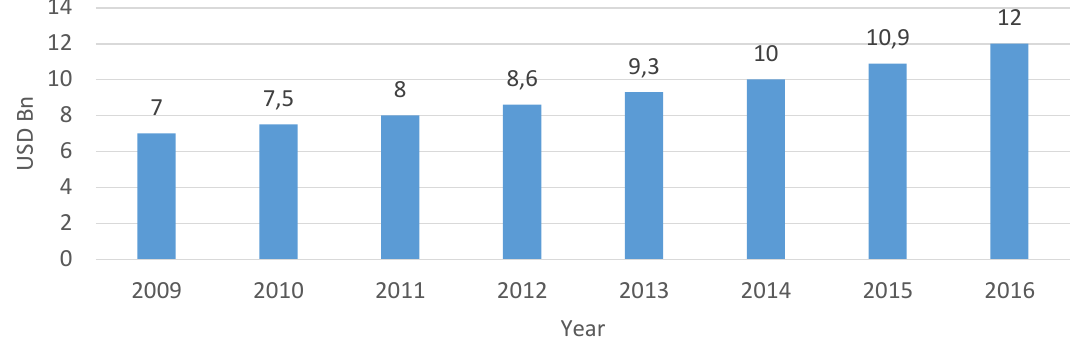
Figure 2. Trends of AML compliance costs in CBRs during 2009-2016 financial